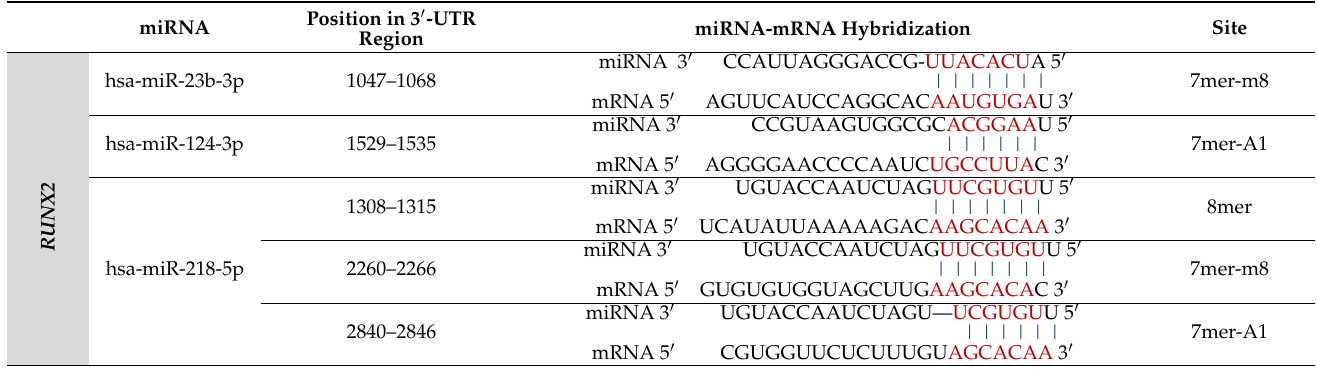
Table 3. miRNA MREs specific for miR-23b-3p, miR-124-3p, and